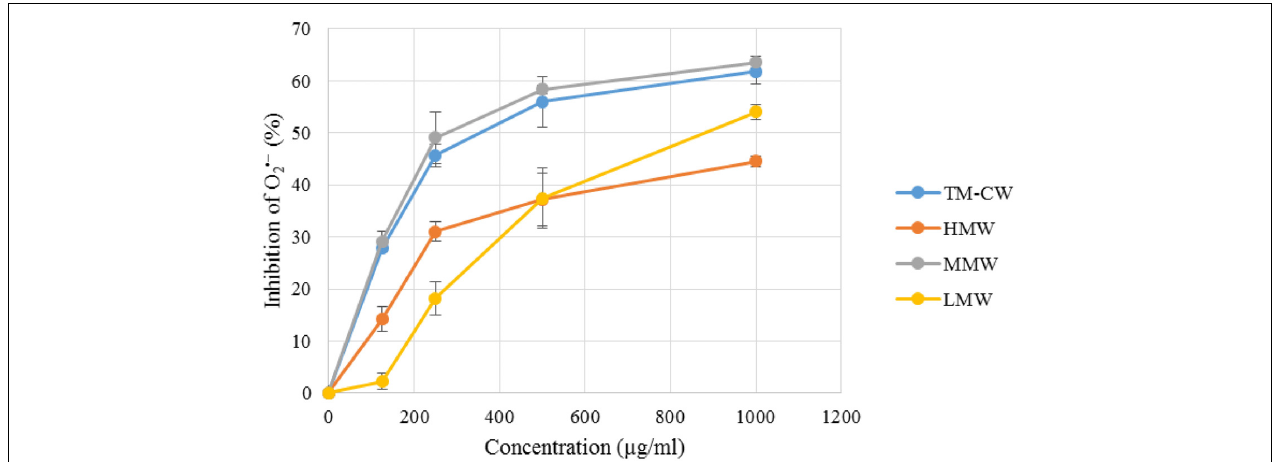
FIGURE 4 | Superoxide anion radical (O •− 2 ) scavenging capacity of L. rhinocerus TM02 sclerotial cold water extract and its Sephadex R (cid:13) G-50 fractions. The scavenging activity was determined by measuring their inhibitory effects on the absorbance of O •− 2 at 570 nm. Values are expressed as percentage inhibition (mean ± SD, n = 3). TM-CW, L. rhinocerus TM02 sclerotial cold water extract; HMW, high-molecular-weight fraction; MMW, medium-molecular-weight fraction; LMW, low-molecular-weight fraction.